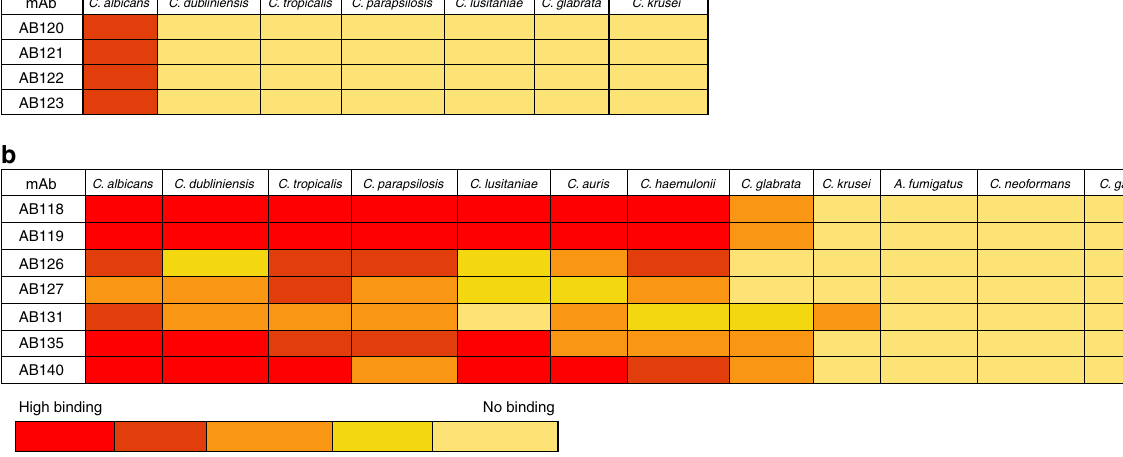
Fig. 7 Heat-map of anti- Candida mAbs binding to Candida and other pathogenic fungi. Immuno fl uorescence microscopy analysis of a anti-Hyr1 mAbs (AB120-AB123) and b cell wall mAbs (one from each clonal cluster) binding to C. albicans and other clinically relevant fungal species under hyphal inducing conditions. Red (high binding) to yellow (no